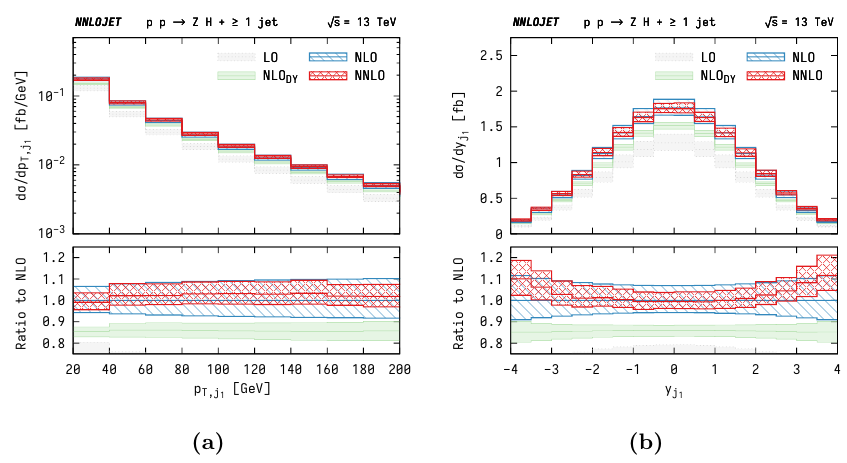
Figure 9. Leading jet observables: (a) transverse momentum and (b)